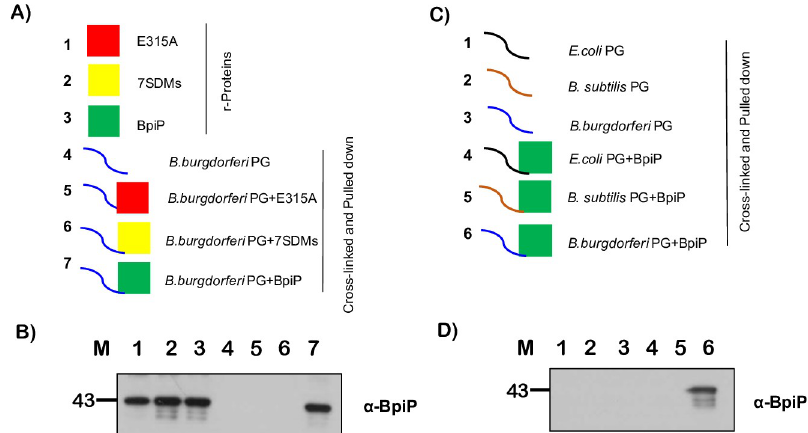
Fig 3. Interactions of BpiP with PG. (A) Schematic representation of recombinant BpiP proteins with site-specific changes at (1) position E315 or (2) with 7 site directed mutations (7SDMs) replacing amino acids of PG-interacting motif of BpiP with alanines or glycine, (3) wild type BpiP, (4) borrelial PG and (5–7) cross-linked complexes of various recombinant BpiP proteins with borrelial PG that were subjected immunoblot analysis. (B) Recombinant BpiP proteins (Lane 1–3), purified borrelial PG (Lane 4) and complexes of recombinant BpiP proteins crosslinked with borrelial PG were precipitated (pulled down) by centrifugation, dissociated via boiling and supernatants were separated as described in the flow chart in S3 Fig (Lanes 5–7) on 12% SDS-PAGE gel, transferred to PVDF membranes. Immunoblot analysis was performed using anti-BpiP serum followed by goat-anti-mouse IgG conjugated with HRPO and blots developed using Enhanced Chemiluminescence. Lanes 1) rE315ABpiP, 2) r7SDM BpiP 3) rBpiP, 4) PG only, 5) rE315A-BpiP cross-linked to PG, 6) r7SDM cross-linked to PG, 7) rBpiP cross-linked to PG. Molecular masses (M) in kilo Daltons are shown to the left. (C) Schematic representation of PG from E . coli , B . subtilis , B . burgdorferi either alone or cross-linked with BpiP and pulled down by centrifugation as complexes. Samples were subjected to boiling and supernatants were separated on 12% SDS-PAGE gel, transferred to PVDF membrane and detected for the presence of BpiP by immunoblot analysis (D) Immunoblot analysis was performed using anti-BpiP serum followed by goat-anti-mouse IgG conjugated with HRPO and blots developed using Enhanced Chemiluminescence. Lane 1) E . coli PG alone, 2) B . subtilis PG alone, 3) B . burgdorferi PG alone, 4) BpiP cross-linked to E . coli PG, 5) BpiP cross-linked to B . subtilis PG, 6) BpiP cross-linked to Bb PG. Molecular masses (M) in kilo Daltons are shown to the